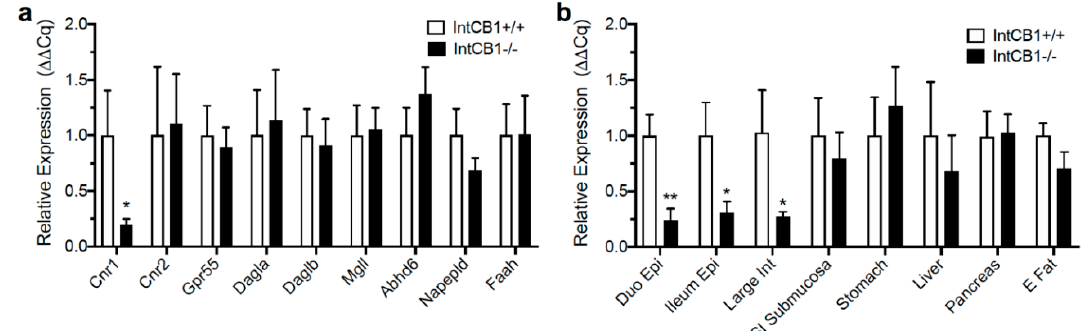
Figure 3. Expression of endocannabinoid system genes in conditional intestinal epithelium-specific CB 1 R-deficient mice and controls. Expression of cannabinoid CB 1 Rs ( Cnr1 ) was reduced in the jejunum epithelium of conditional intestinal epithelium-specific CB 1 R deficient mice (IntCB1 − / − ) when compared to control mice (IntCB1+/+)(a), and expression of mRNA for other components of the endocannabinoid system was unaffected, including cannabinoid CB 2 Rs ( Cnr2 ), g-protein coupled receptor 55 ( Gpr5 ), diacylglycerol lipase alpha ( Dagla ), diacylglycerol lipase beta ( Daglb ), monoacylglycerol lipase ( Mgll ), alpha beta hydrolase domain containing 6 ( Abhd6 ), N-acyl- phosphatidylethanolamine-hydrolyzing phospholipase D ( Napepld ), and fatty acid amide hydrolase ( Faah )(a). IntCB 1 − / − mice, when compared to IntCB1+/+ controls, were deficient in expression of mRNA for CB 1 Rs ( Cnr1 ) in the duodenum epithelium (Duo Epi), ileum epithelium (Ileum Epi), large intestine (Large Int), but not in the small-intestinal submucosa/muscle/serosal layers (SI Submucosa), stomach, liver, pancreas, and epididymal fat (E Fat)(b). Unpaired Student’s t -tests, two-tailed; * = p < 0.05, ** = p < 0.01. Results are expressed as means ± S.E.M; n = 5–8 per condition. IntCB 1 − / − and IntCB 1 +/+ control mice displayed similar body weights (Figure 4a, p = 0.404), and baseline 24-h caloric intake (Figure 4b, p = 0.52), 24-h water intake (Figure 4c, p = 0.487), average meal size (Figure 4d, p = 0.653), ambulation (Figure 4e, p = 0.741), and glucose clearance during an oral glucose tolerance test (Figure 4f,g; 15, 30, 60, 120 min, ns; total area under curve, p = 0.847).